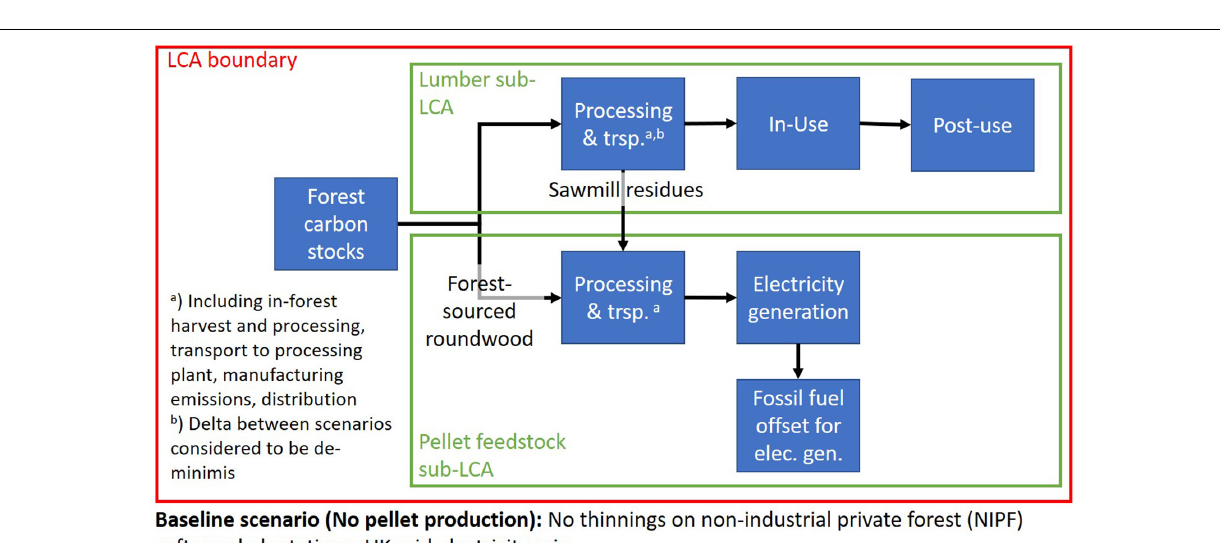
Frontiers in Forests and Global Change |